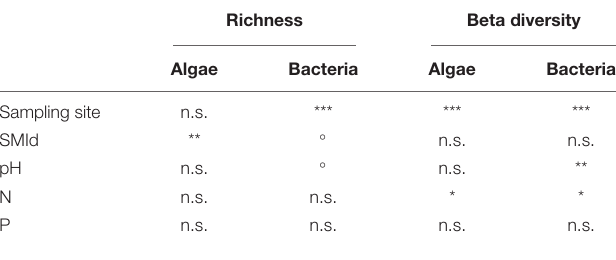
TABLE 2 | Correlation of environmental factors with the richness (based on ANOVA results) and the community composition (based on PERMANOVA